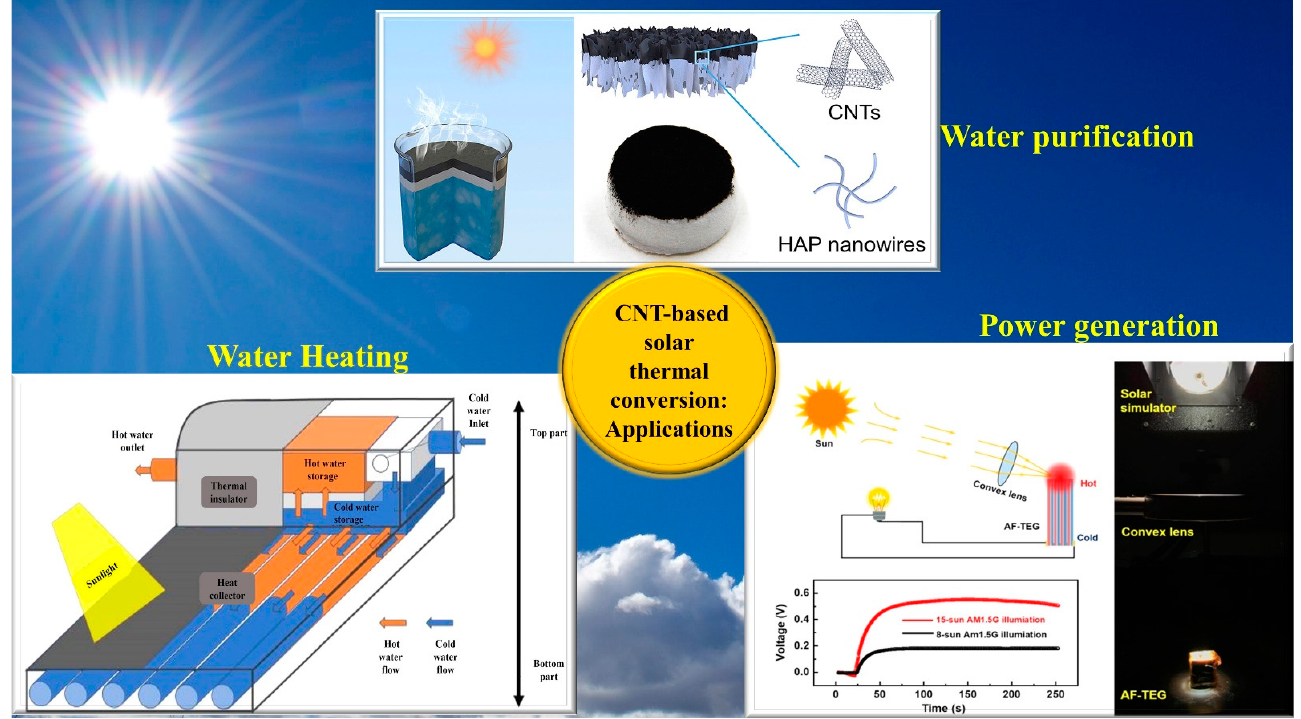
Figure 1. Recent applications of CNT-based solar thermal devices for water purification, power generation, and water heating (reproduced with permission, Copyright 2021 Elsevier [36]; reproduced with permission, Copyright 2019 Elsevier [37].)